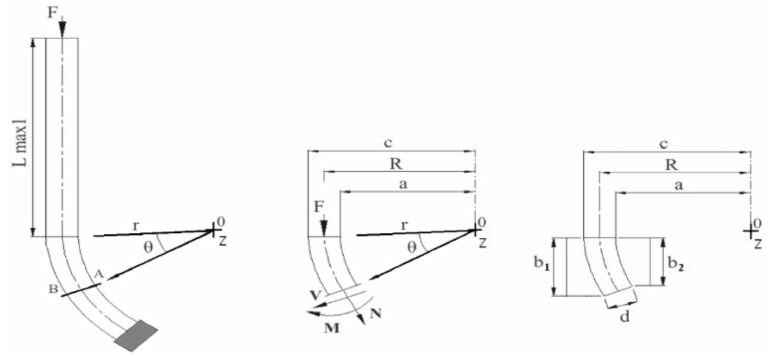
Figure 8. Free body diagram foot